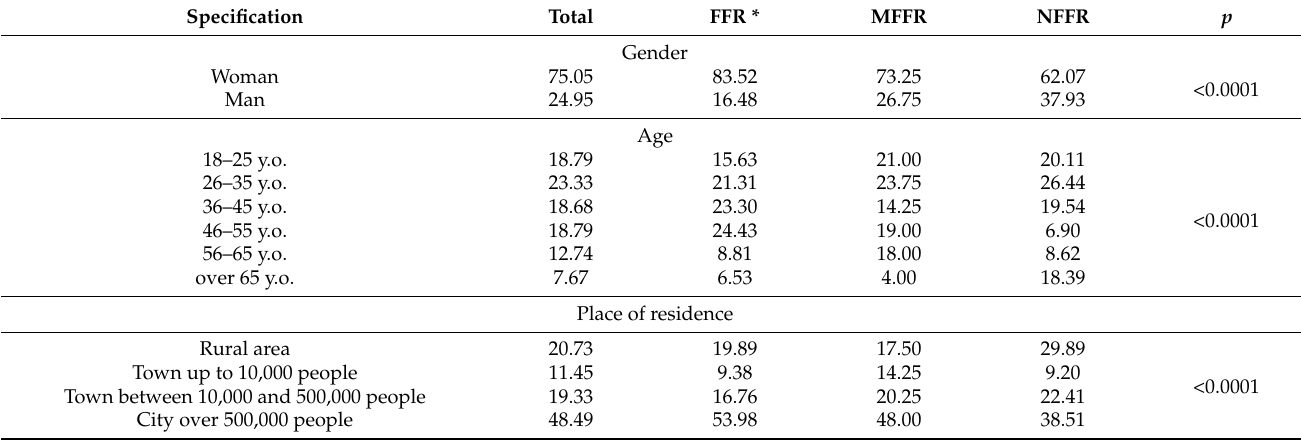
Table 2. Study population and isolated cluster characteristics including socio-demographic and economic features.